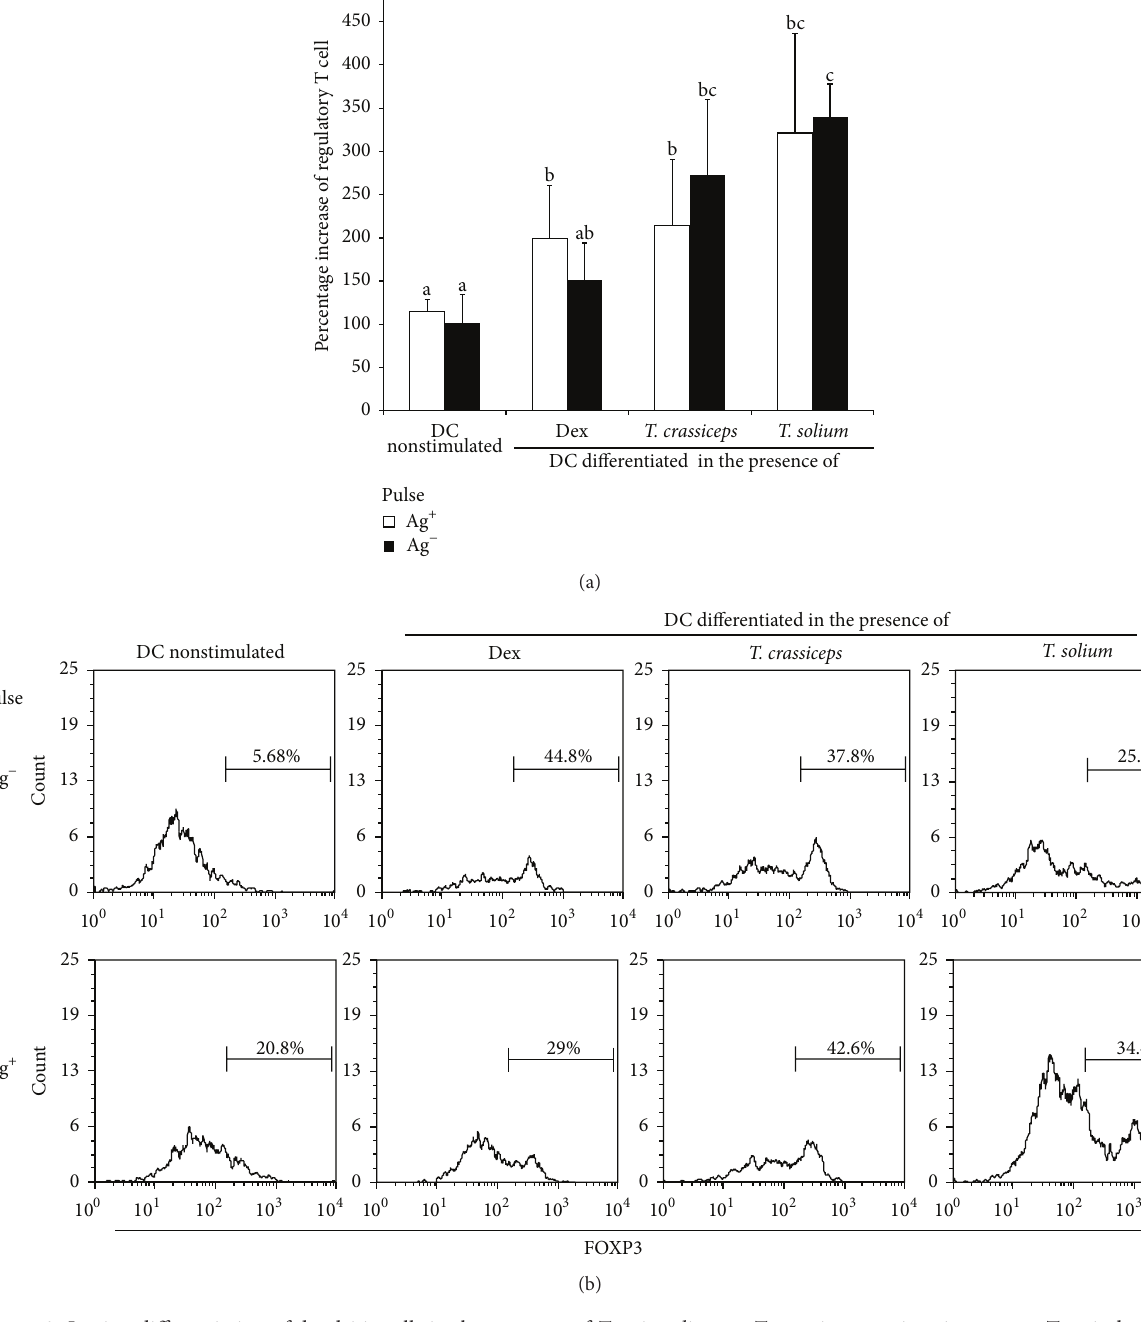
Figure 2: In vitro differentiation of dendritic cells in the presence of Taenia solium or T. crassiceps cysticerci promotes Treg induction. (a) Increased percentage in Treg cell induction. Percentage was calculated as follows: (percentage of Tregs induced/percentage of basal Tregs) × 100. Different letters indicate significant differences between groups at 𝑃 < 0.05 . (b) Representative histograms showing Foxp3 induction within CD4 + CD25 high cells. Data are representative of three independent